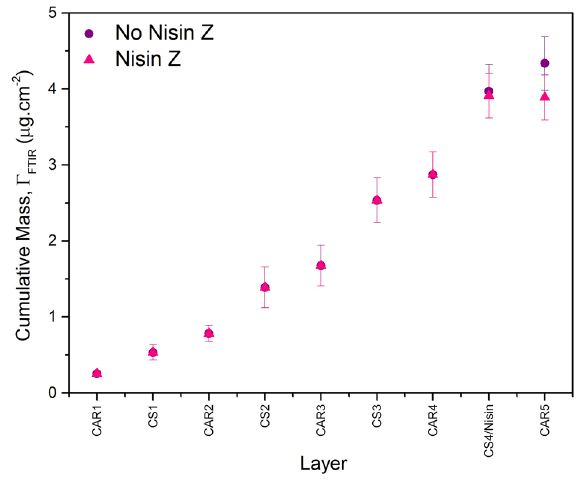
from three independent